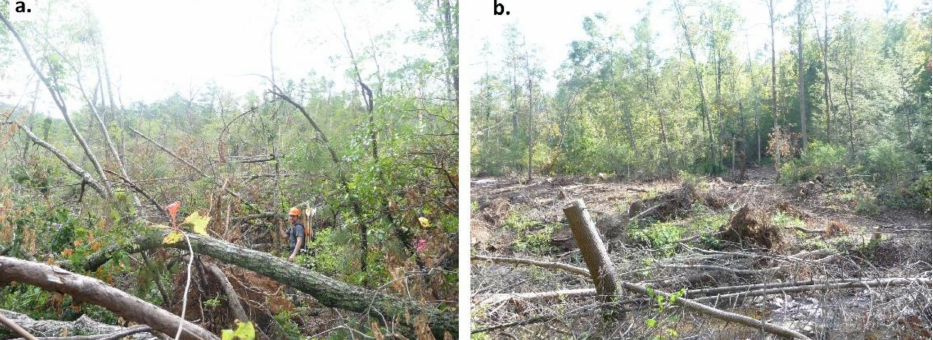
Figure 1. A study site in the Chattahoochee-Oconee National Forest shortly after the 2011 windthrow ( a ), and after salvage logging ( b